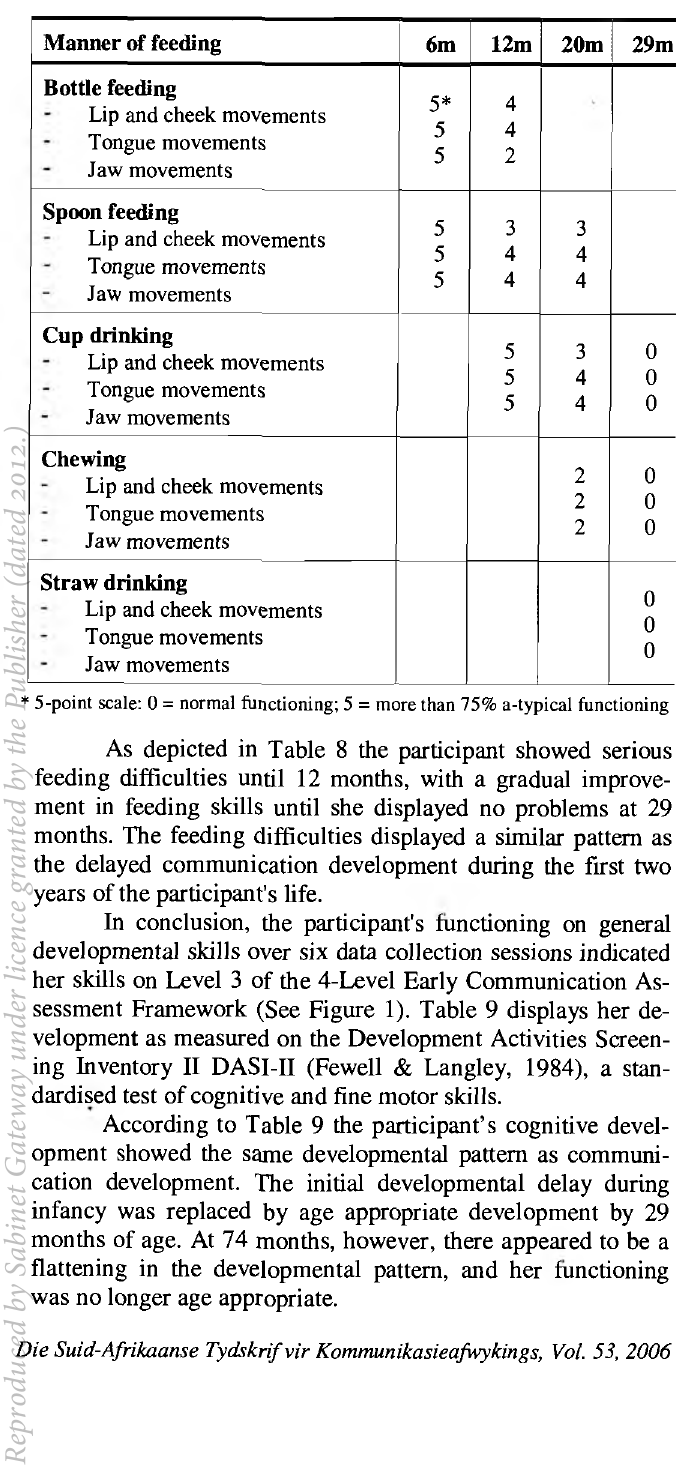
Table 8: Development of the participant’s feeding skills according to the Oral-Motor/Feeding Rating Scale (Jelm, 1990).